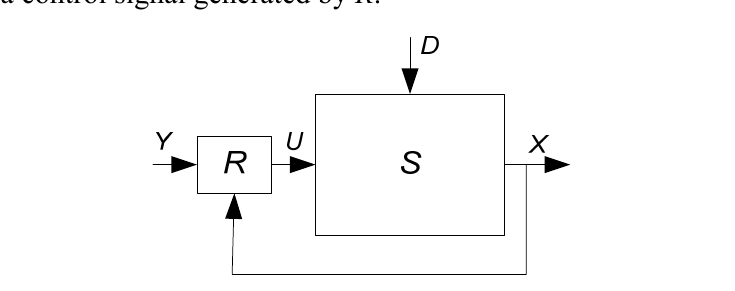
Figure 4. Feedback controlled system. R ( Reconfigurator) is a decision making body or controller. U is a control signal generated by R .